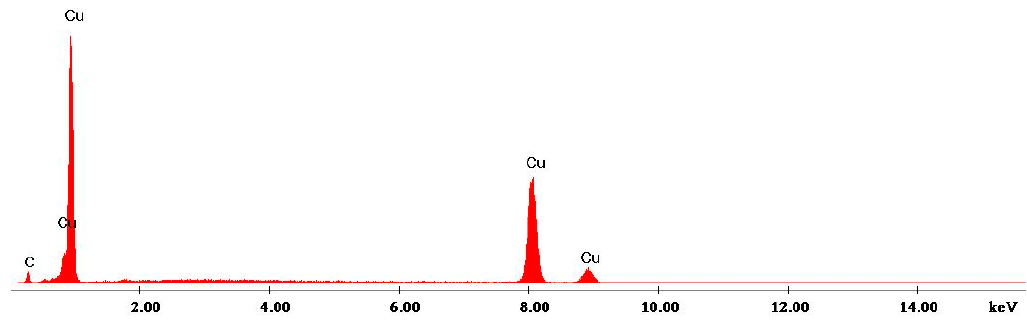
Figure 39. EDS spectrum acquired on the rounded inclusions, exclusively made of Cu (SP5 orange/red plant ash-based glass tessera from the Basilica of St. Peter, Rome, Italy [26]).